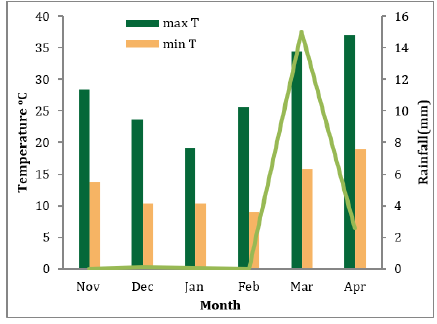
Figure 1: Mean monthly maximum temperature, minimum temperature and rainfall of experimental site during the wheat growing season ( Source : Department of Hydrology and Meteorology)